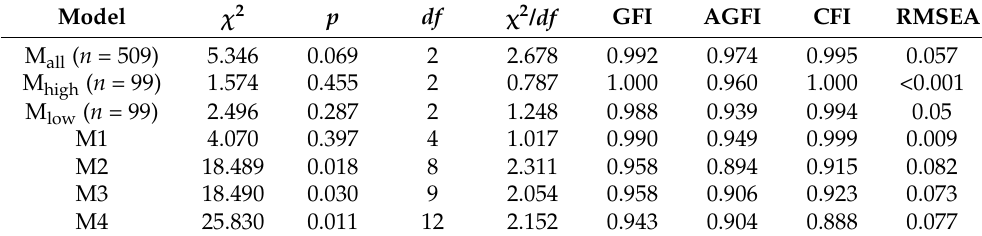
Table 2. The results of simultaneous analysis of several groups.